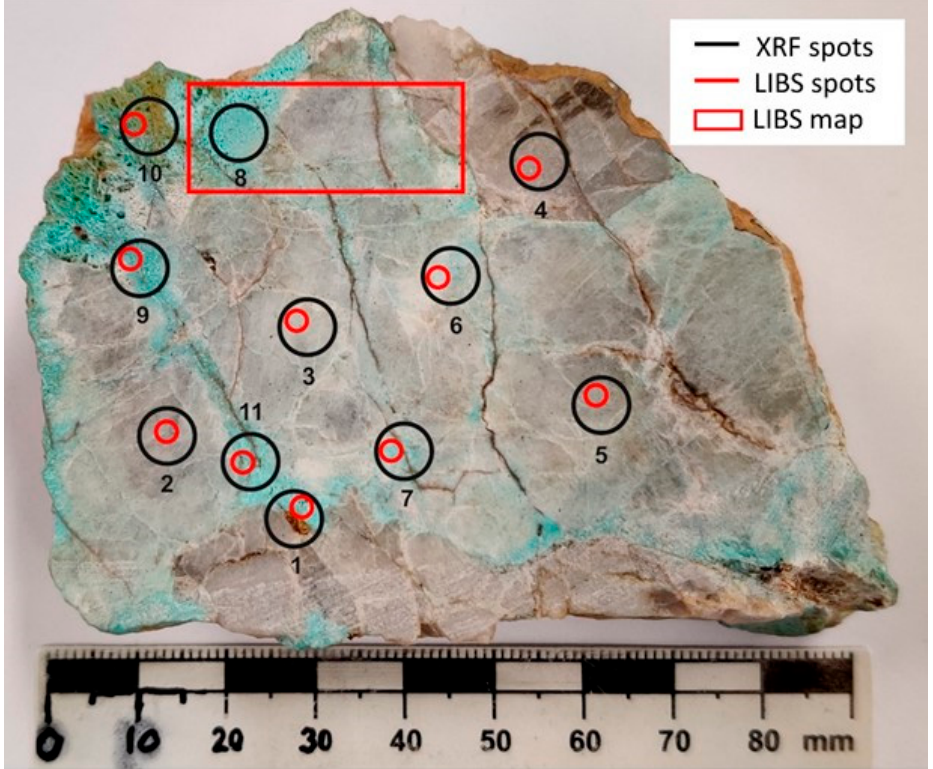
Figure 3. Hand sample of montebrasite, quartz and turquoise, with the different spots measured by XRF and LIBS. Within each LIBS spot, five shots were performed at three different points, giving a total of 15 shots. Table 1. Bruker S1 Titan. GeoMining Calibration (P/N: 730.0203). Sample prep: All calibration samples were prepared as dry sample powders packed into a sample cup and measured through a 4 micron foil. Limit of detection (LOD) specified for SiO 2 matrix in three sigma 99.7% confidence level and 180 s analysis time in 3-phase mode (60 s per phase). Calibration range: This is based on available reference materials and can be extrapolated up to 10% (relative) over the highest value. The calibration for Ba, La, and Ce was made using K-alpha and K-beta lines, and the other elements were calibrated using the K and L lines (Bruker 2017).